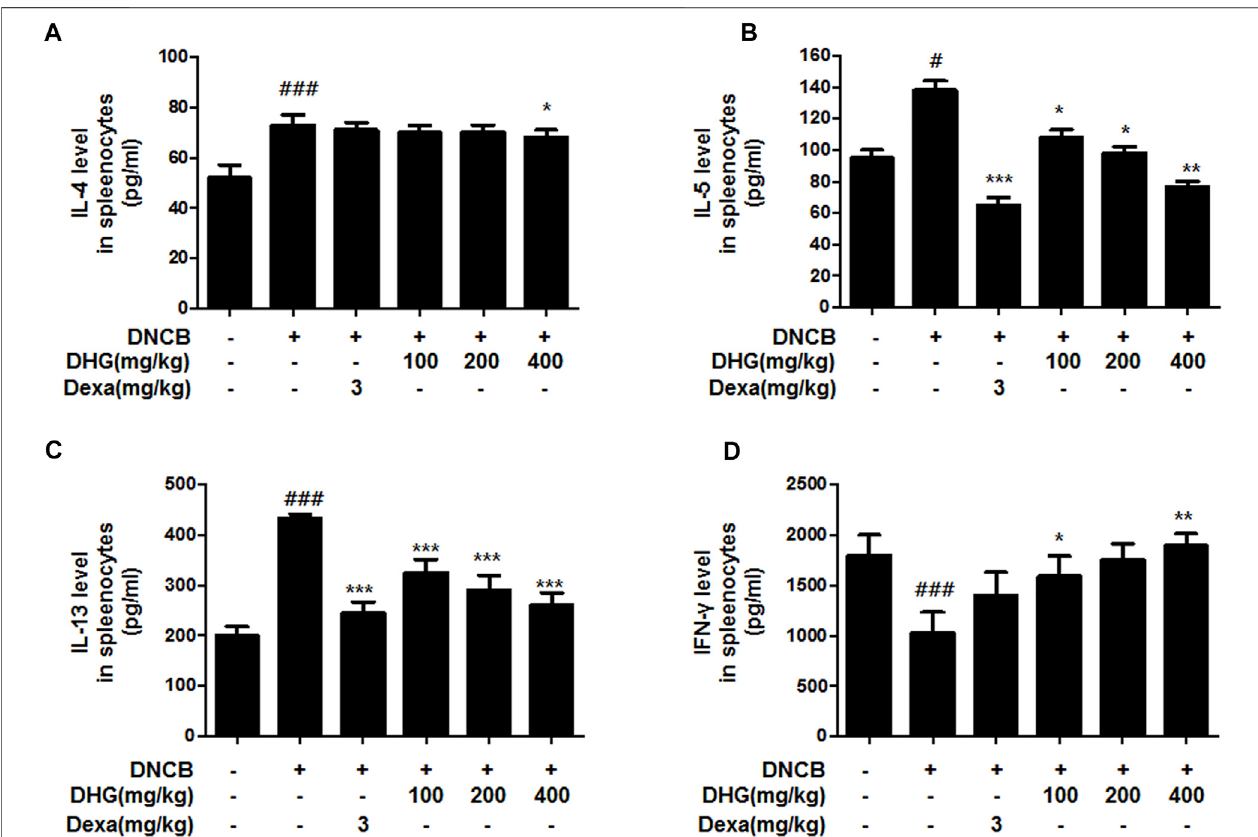
FIGURE 2 | The effects of DHG on the production of IL-4 (A) , IL-5 (B) , IL-13 (C) and IFN- γ (D) by cultured splenocytes in NC/Nga mice (total n = 6/group). Splenocytes from mouse at 15 weeks of age were re-stimulated with CD3 mAb (0.5 μ g/ml) for 48 h. IL-4, IFN- γ , IL-5, and IL-13 levels were measured by a sandwich ELISA. # p < 0.05, ## p < 0.01, ### p < 0.001 (compared with NC/Nga-Nr). * p < 0.05, ** p < 0.01, and *** p < 0.001 (compared with DNCB-CTL).